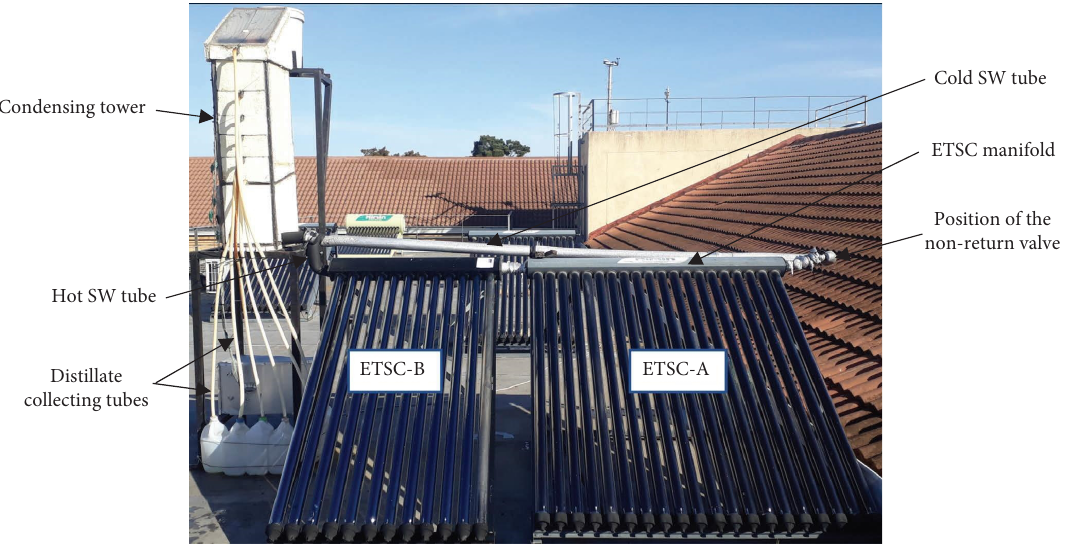
Figure 3: ETSCs and condensing tower view of the vapour-based (Figure 2). Tere are several factors afecting and infuencing